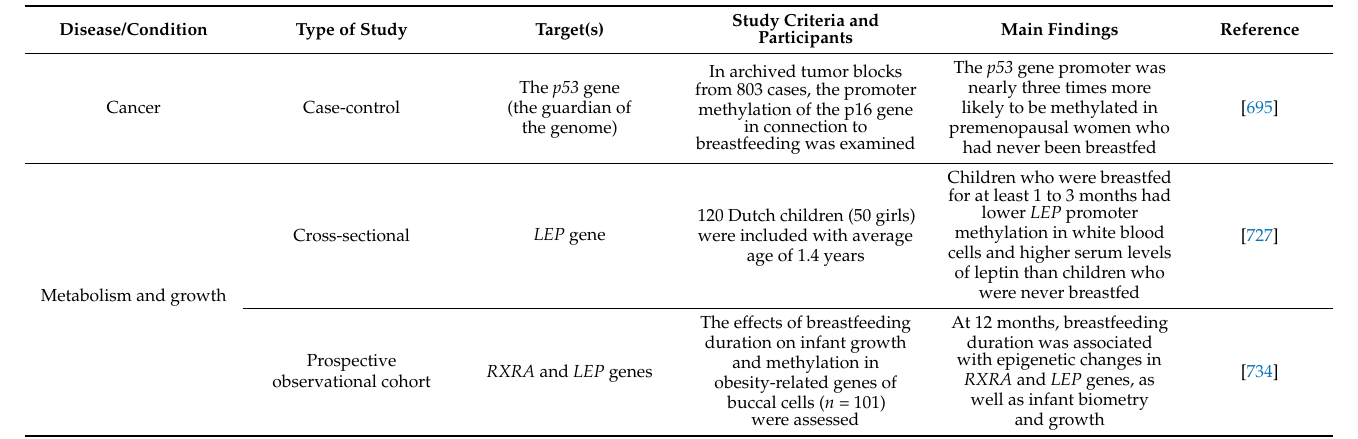
Table 4. List of studies that investigated the epigenetic effects of breastfeeding on different physiolog- ical and pathological functions in infants and